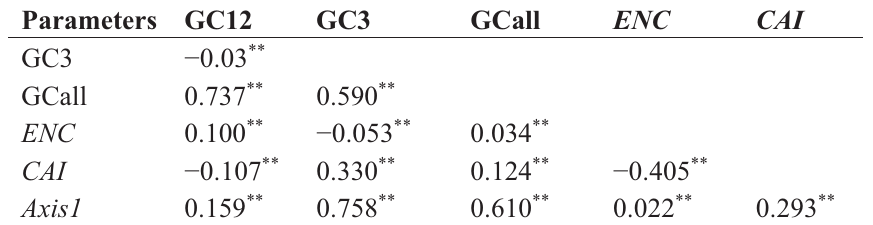
Table 1. Correlation analysis of P . lactiflora gene-related parameters. GC3, GC content at the third synonymous codon position. CAI, Codon Adaptation Index.